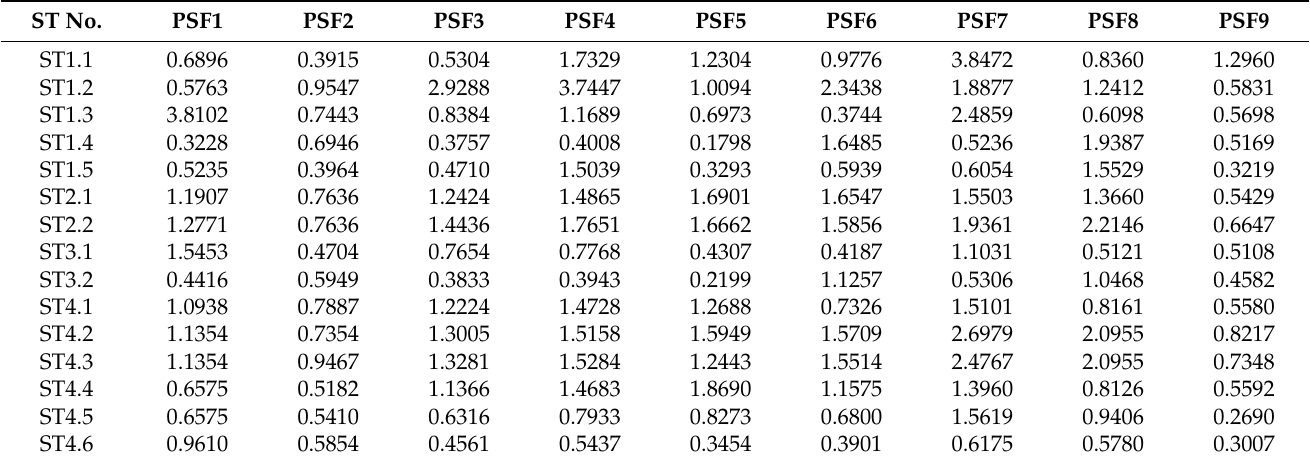
Table 15. The risk value of each PSF in each ST through the traditional